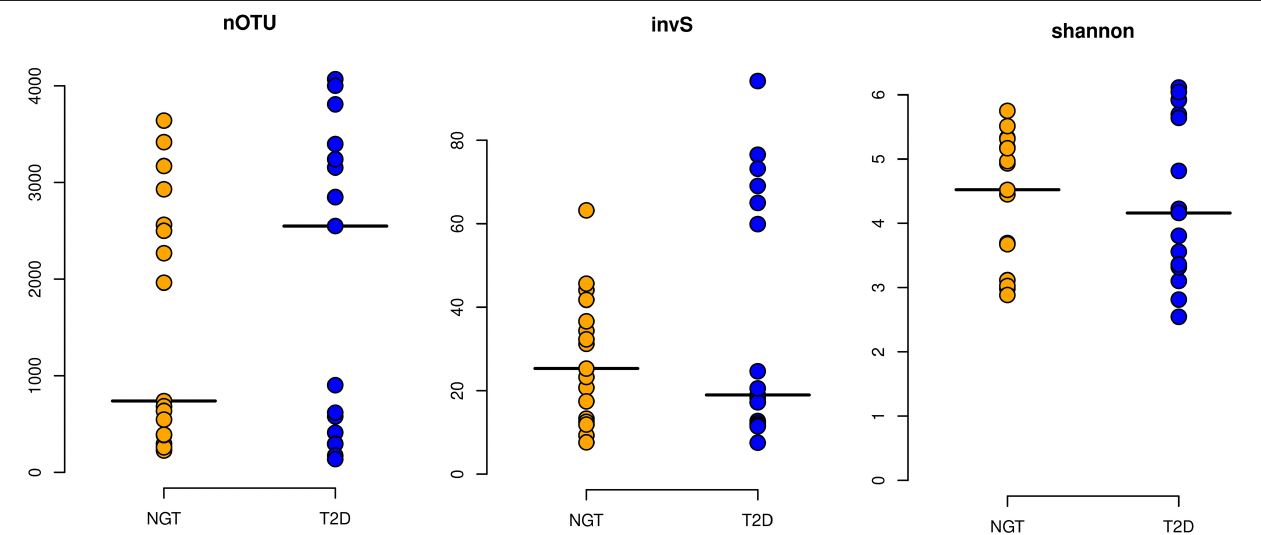
FIGURE 2 | Alpha diversity Indices. The alpha diversity of the studied groups was measured based on their richness [nOTU and inverse Simpson index (invS)] and evenness [Shannon Index (shannon)]. Here horizontal lines in the plot represent their respective mean